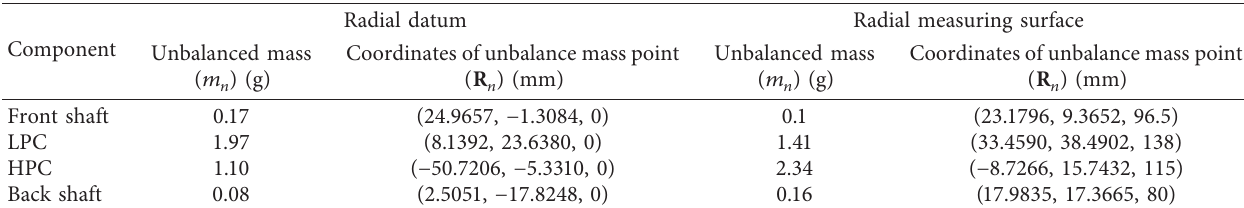
Table 8: The mass parameters of the 4-stage